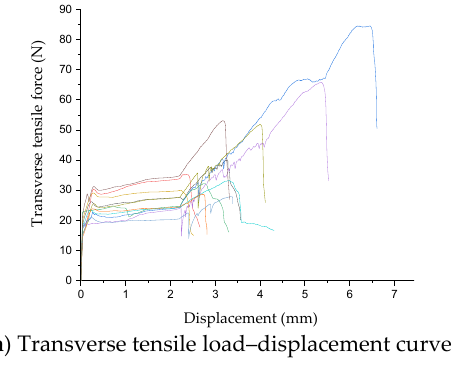
Figure 7. Transverse tensile test results of jujube bark: A is approximately the dividing point between elastic stage and yield stage; B is approximately the dividing point between yield stage and strengthening stage; C is the point of tensile strength.